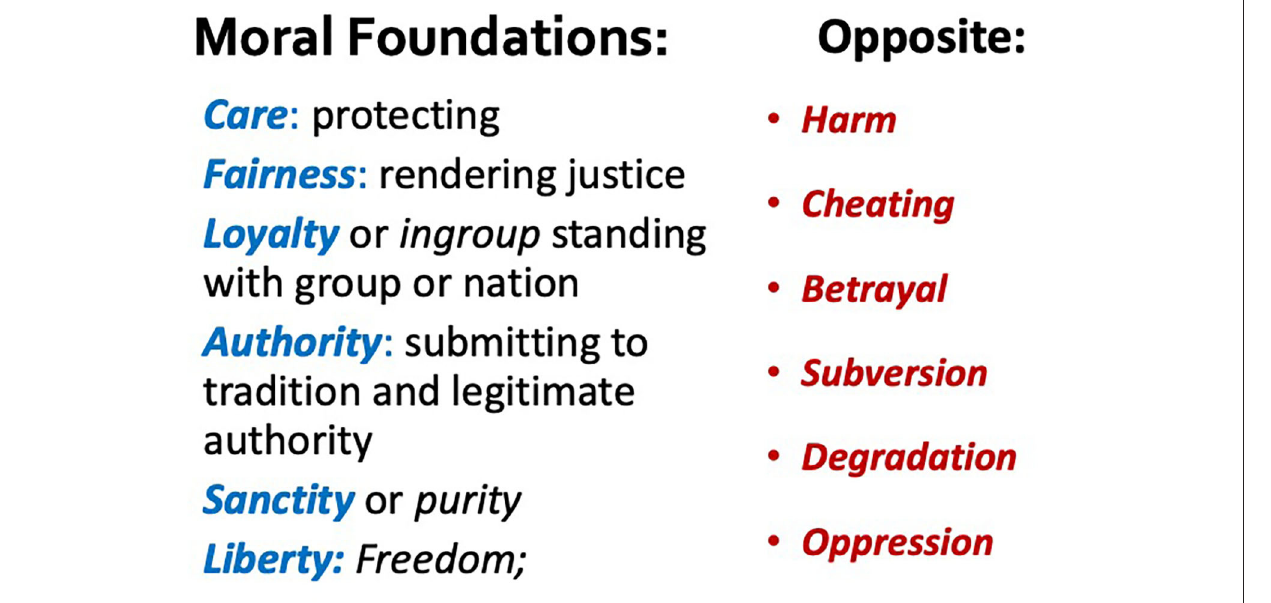
FIGURE 1 | Moral foundations theory.